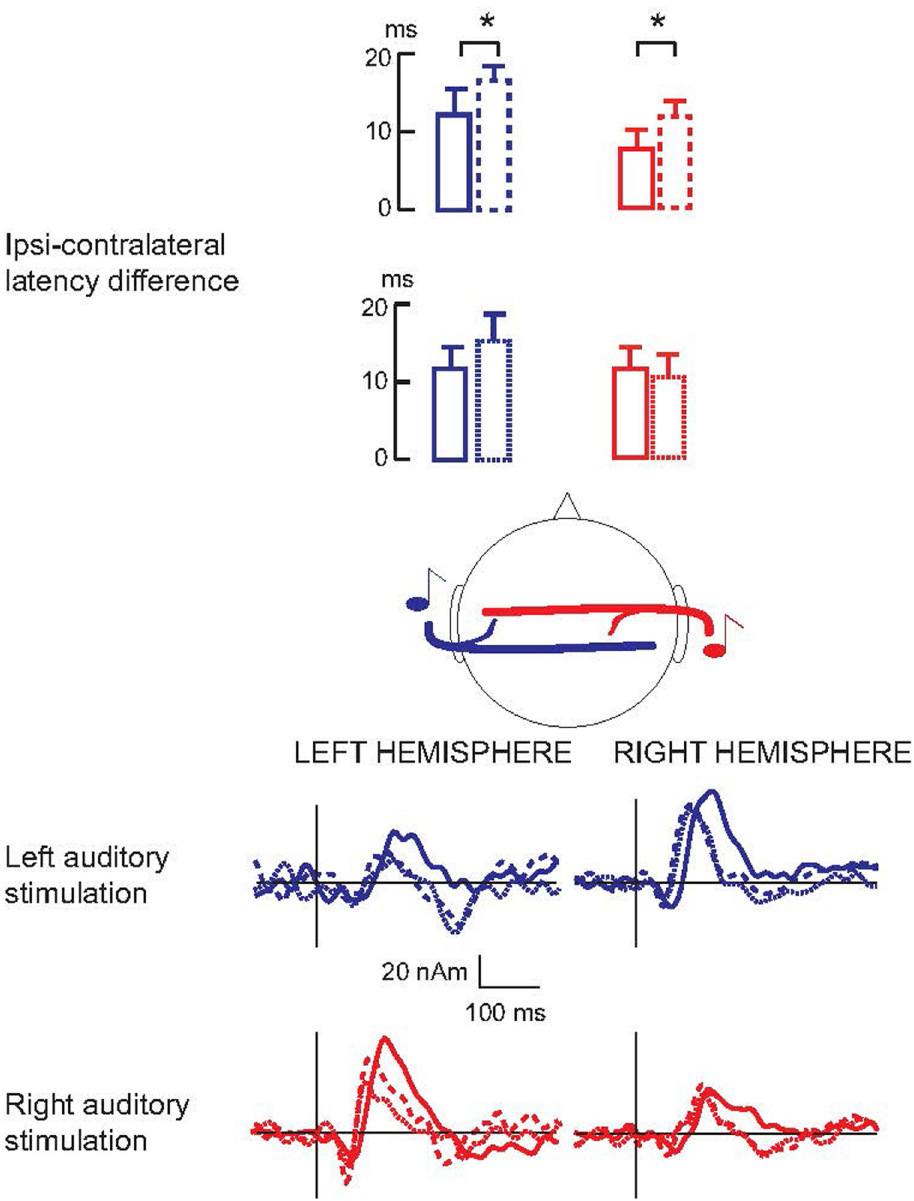
Fig 2. The interhemispheric latency difference increased from preoperative to postoperative DBS on condition. Bottom: N100m source strengths as a function of time in one subject to both left- (blue) and right-sided (red) auditory stimulation in preoperative (full line), DBS on (dashed line), and DBS off (dotted line) conditions. Top: Comparison of the interhemispheric latency differences in both hemispheres in preoperative (full line) and DBS on (dashed line) conditions (n = 15), and in preoperative (full line) and DBS off (dotted line) conditions for the subjects who tolerated DBS off condition (n =